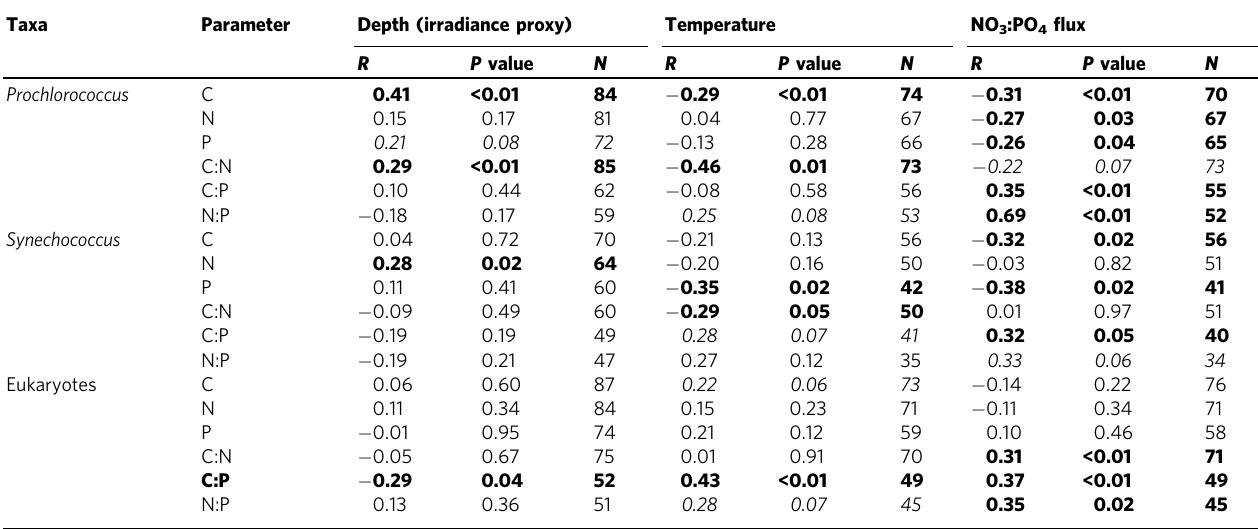
Table 1 Correlations between measured environmental variables and cellular contents and stoichiometric ratios for each taxonomic